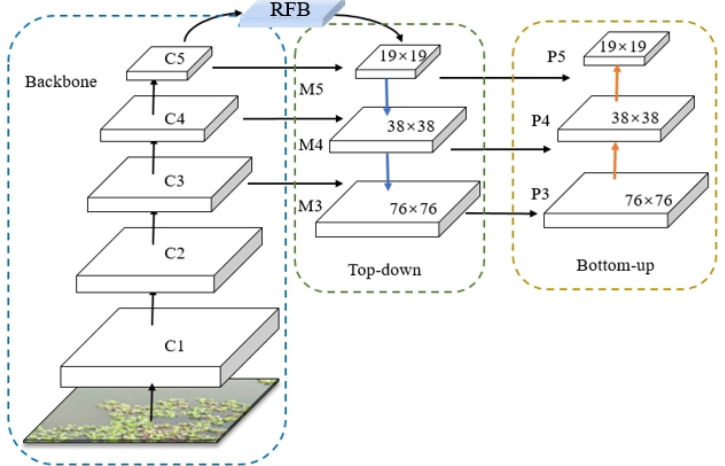
Figure 8. Feature fusion network